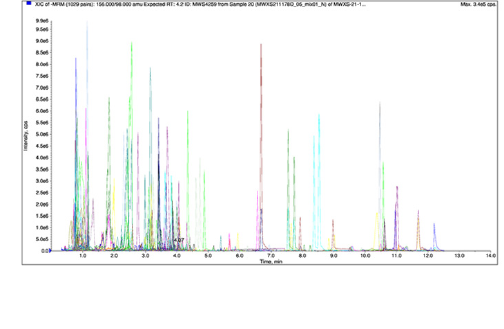
( B ) Figure 3. Multi-peak figure for MRM metabolite detection (each different colored mass spectrum peak represents one metabolite detected). ( A ) Negative ion mode. ( B ) Positive ion mode.